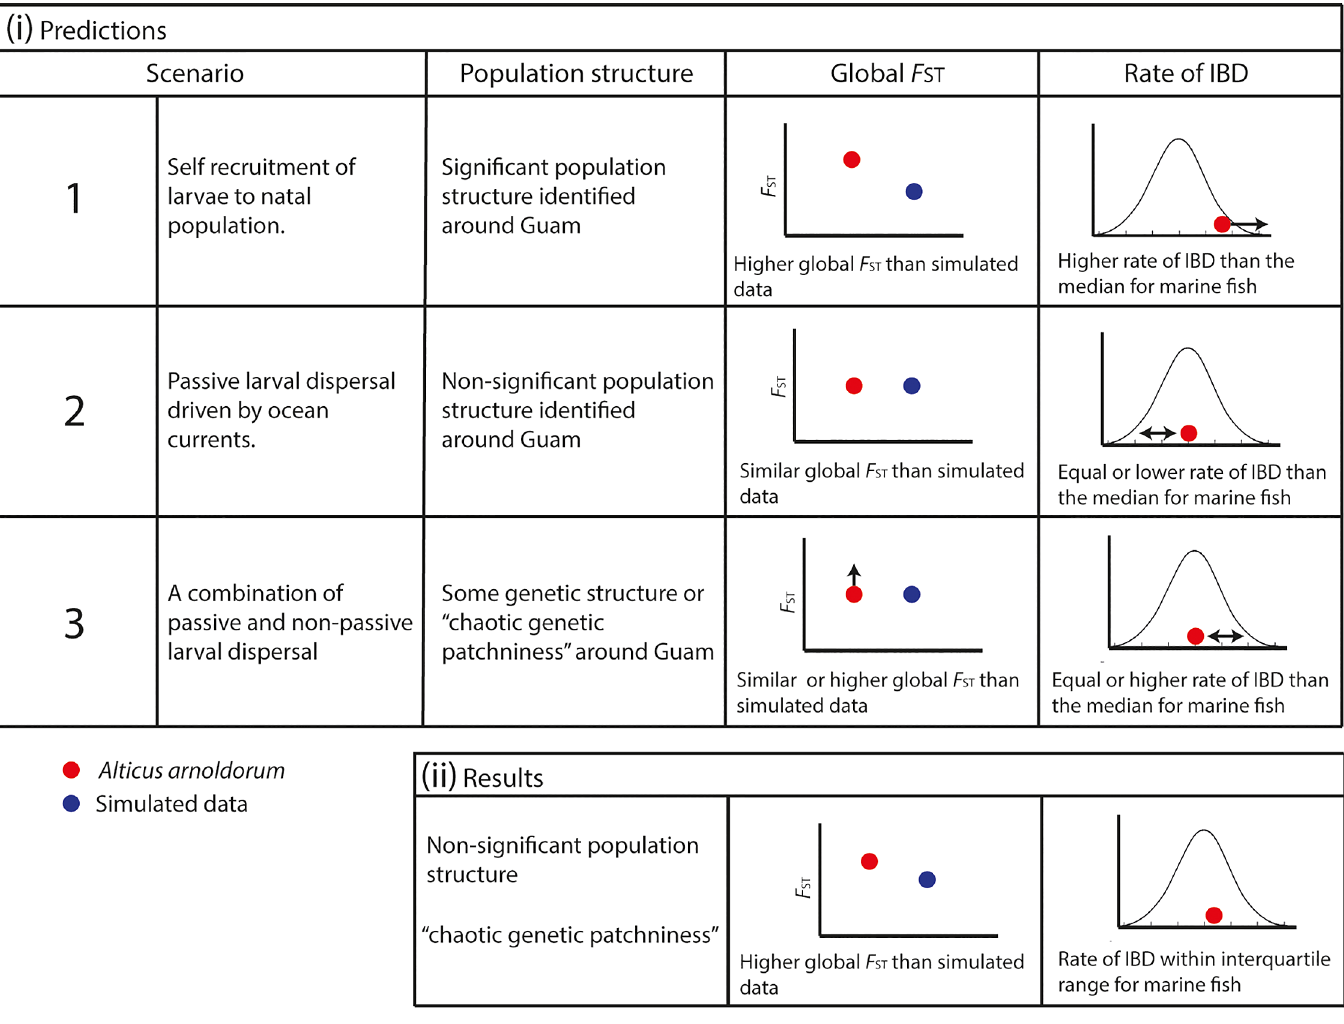
Fig 3. Scenarios of how the behaviour of larvae might impact genetic connectivity (i) Predictions based on realistic dispersal scenarios of Alticus arnoldorum incorporating empirical, simulated and meta-analyses results. (ii) Schematic illustrating the results from Alticus arnoldorum compared to the simulated and meta-analysis